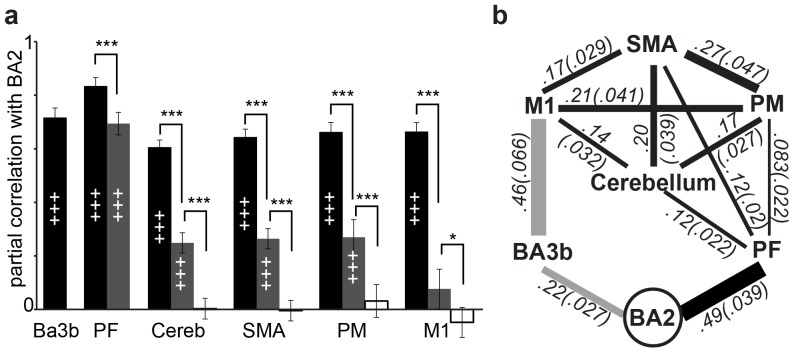
Partial Correlation and ICOV analysis results.(a) Partial correlation between BA2 and the key ROIs revealed by the PPI analysis as a function of the variance that has been removed (task only, black bars; task and BA3b, gray bars; task and BA3b and PF, white bars). ***: one tailed paired t-test p<0.001 Bonferroni-corrected for 5 ROIs (task only vs. task and BA3b removed) or 4 ROIs (task and BA3b vs. task, BA3b and PF). *: same at p<0.05. +++: one-tailed t-test against zero, p<0.001, Bonferroni-corrected for 6 ROIs (task only), 5 ROIs (task and BA3b) or 4 ROIs (task and BA3b and PF). (b) ICOV analysis revealing the pattern of direct connectivity between the selected ROIs. Connection strength (visually presented as line thickness), as average partial correlation value (± standard deviation), is indicated on each significant partial correlation. Connections between the nodes represent all the significant partial correlations (at p<0.05, bonferroni corrected for 21 possible pair-wise correlations, two-tailed t-test). Connections in grey are likely to represent re-afference through the body loop, those in black neural connections that could carry efference-copy signals.